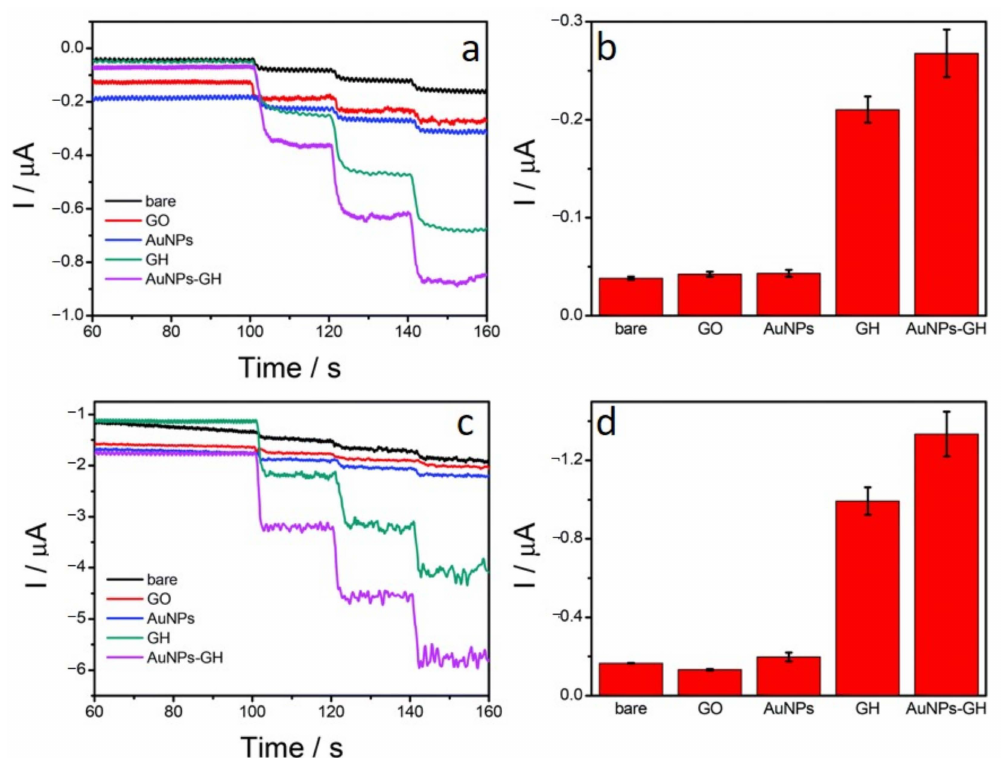
Figure 9. Amperometric responses towards IAA ( a ) and SA ( c ) on various electrodes in 0.1 M PBS with a pH value of 2.5. The corresponding values of the steady current towards IAA ( b ) and SA ( d ) on various electrodes. The concentration of the added IAA and SA was 20 µ M. The working potentials for IAA and SA were set at 0.8 V and 1.25 V, respectively. Reproduced from Ref. [87] with permission from the Royal Society of